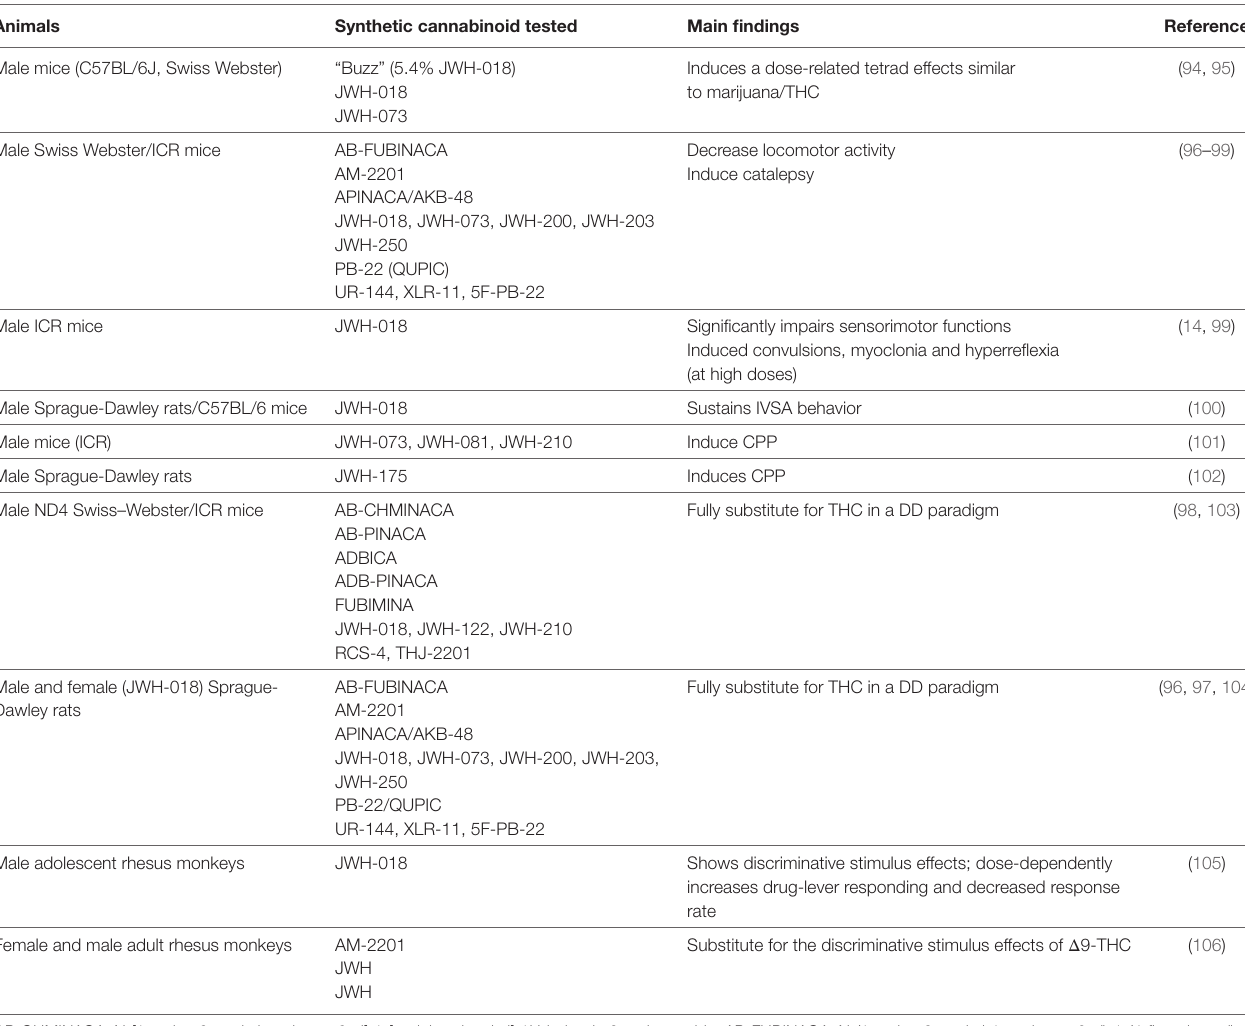
TabLe 2 | Studies investigating the behavioral effects of synthetic cannabinoids.